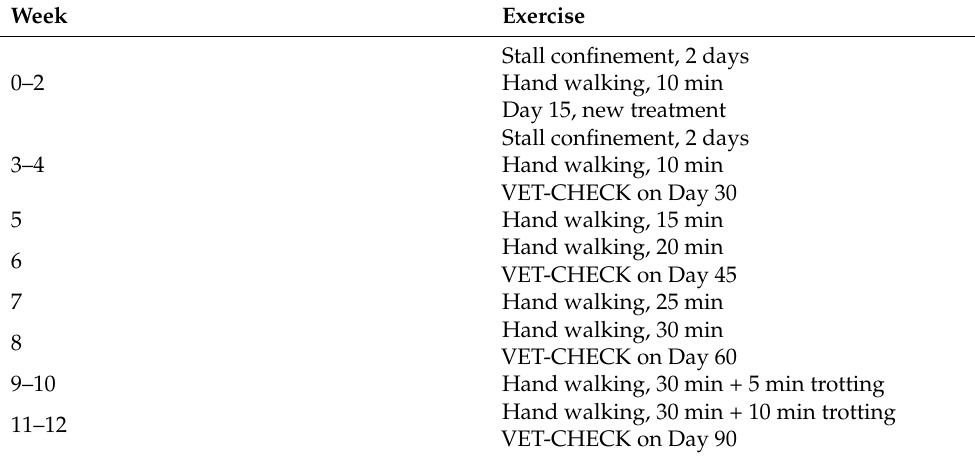
Figure 3. Timeline of the eSM-MSC treatment protocol and rehabilitation program. The day before the first treatment (T0), blood from the equine patient was collected to prepare autologous serum. At T0, the mixture of autologous serum and eSM-MSCs was injected intralesionally after a clinical and ultrasound examination. After 15 days, the same procedure was repeated. At day 30 (T2), a clinical and ultrasound examination was performed and if a favorable outcome was considered, the horse progressed to a physical rehabilitation program. During the physical rehabilitation program, the equine patient was also re-evaluated at days 60 and 90. Table 5. Physical rehabilitation program. After eSM-MSC treatment, all horses were submitted to a rehabilitation program consisting of two days of box rest followed by 13 days of 10 min of hand walking. The bandage applied on treatment day was removed 24 h after treatment. At Day 15, the second treatment was performed followed by another 15 days of rehabilitation, until Day 30. Between Days 30 and 45, the work consisted of 20 min hand walking; between Days 45 and 60, the work was 30 min of hand walking; between Days 60 and 75, the work was 30 min of hand walking plus 5 min trotting; and finally, between Days 75 and 90, each horse was submitted to 30 min of hand walking plus 10 min of trotting. After this, the horses could return to full work.